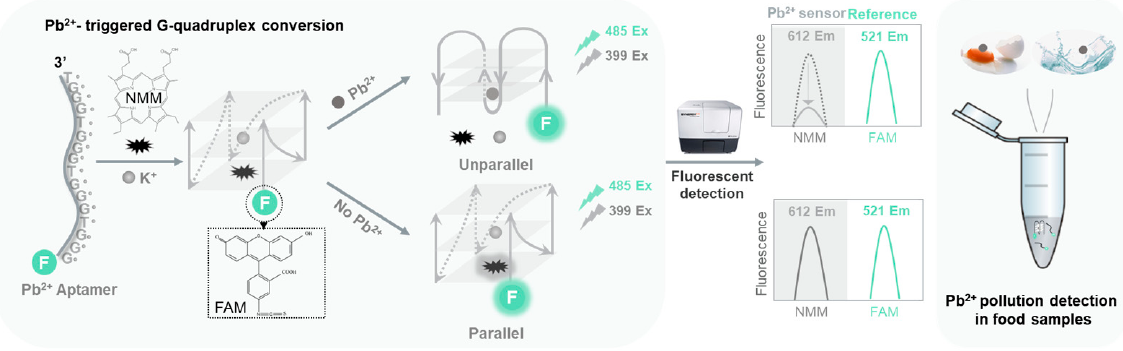
Figure 1. Working principle of the aptasensor and its application for Pb 2+ pollution detection. NMM refers to N-methyl Mesoporphyrin IX, and FAM refers to 6-carboxy-fluorescein.